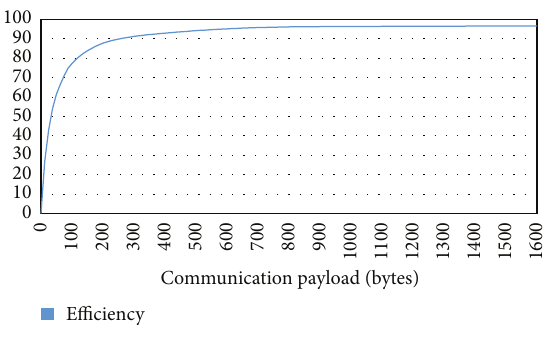
Algorithm 4: Storage Role Description.